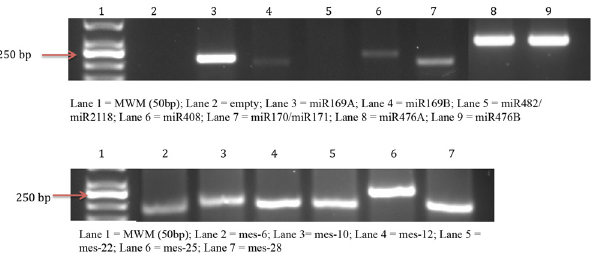
Fig 5. Cassava miRNA RT-PCR expressional validation of the identified (A) conserved cassava miRNAs and (B) novel cassava specific miRNAs. The product of each sample was separated on a 2% agarose gel. (A) Lane 1 = MWM (50bp); Lane 2 = empty; Lane 3 = miR169A; Lane 4 = miR169B; Lane 5 = miR482/miR2118; Lane 6 = miR408; Lane 7 = miR170/miR171; Lane 8 = miR476A; Lane 9 = miR476B. (B) Lane 1 = MWM (50bp); Lane 2 = mes-6; Lane 3 = mes-10; Lane 4 = mes-12; Lane 5 = mes-22; Lane 6 = mes-25; Lane 7 = mes-28.